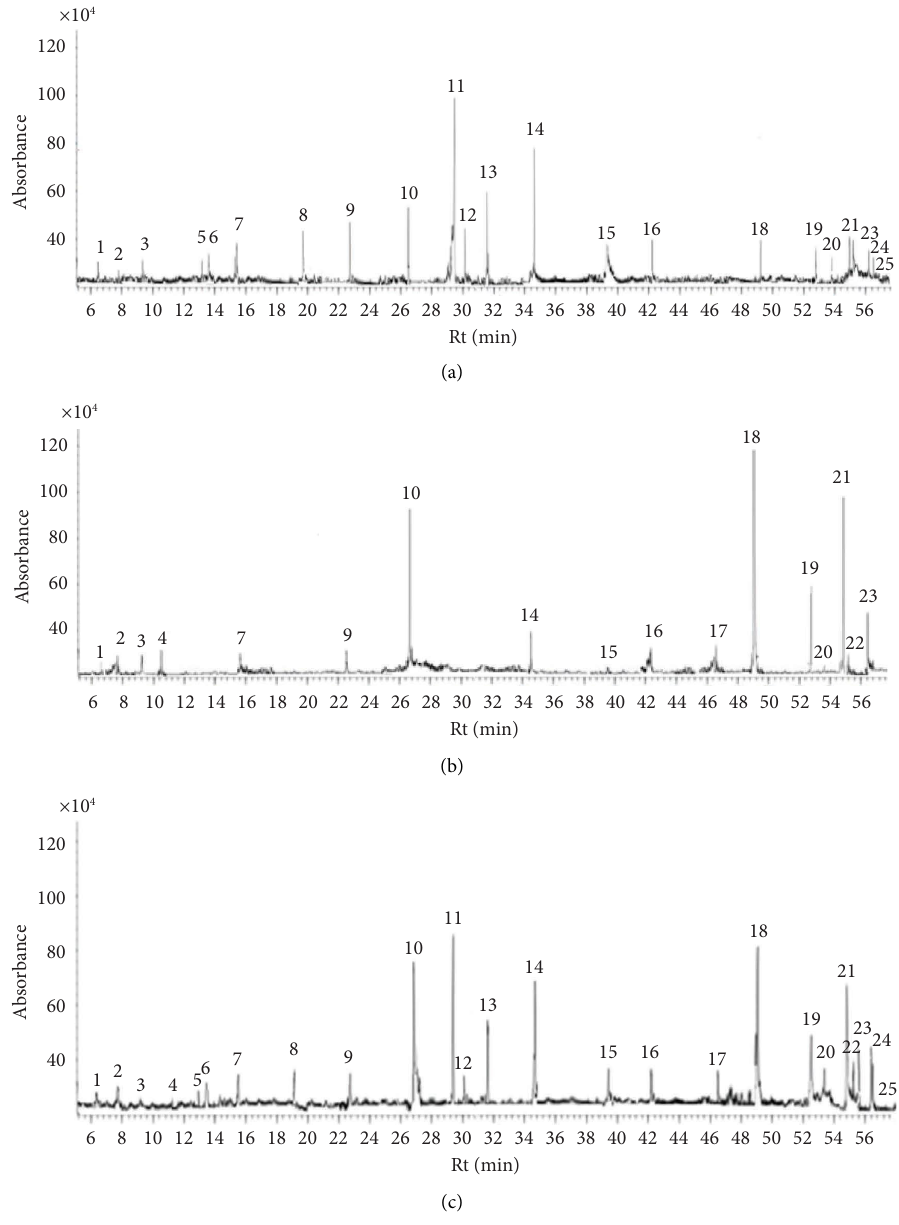
Figure 2: GC-MS chromatograms of thyme, (a) sage, (b) and thyme–sage mixture (c) methanolic extract. 1: Cafeic acid, 2: β -pinene, 3: sabinene, 4: carnosol, 5: ocimene, 6: p-coumaric acid, 7: ferulic acid, 8: cafeoylquinic acid derivative, 9: carnosic acid, 10: rosmarenic acid, 11: thymol, 12: quercetin-7-o glucoside, 13: cinnamic acid, 14: carvacrol, 15: ferulic acid derivative, 16: methyl rosmarenate, 17: meth- ylcarnosate, 18: apigenin, 19: luteolin-7-o-rutinose, 20: cirsiliol, 21: apigenin-7-glucoside, 22: salvigenin, 23: naringnin, 24: luteolin, and 25: hesperidin. Table 3: Te mean ± SD ( n � 3) of comparison between the antioxidant activities of thyme, sage, thyme–sage extract, and BHT solution. Plan extract / BHT solution